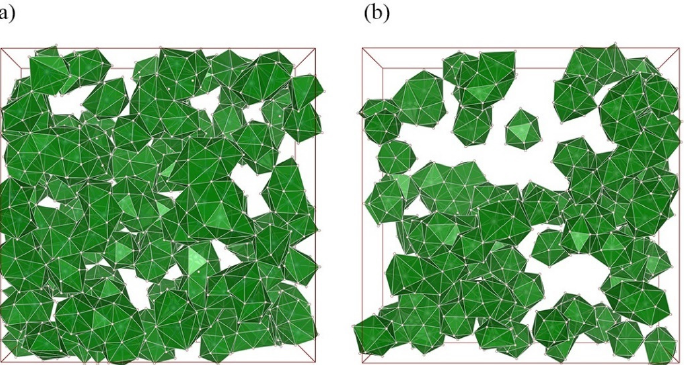
Figure 7. The distribution of FIs and their networking in the simulated cells for the Al 35 Mg 35 Zn 30 and Al 25 Mg 25 Zn 50 metallic glasses. For clarity, only the front half of the icosahedral network is shown in both ( a , b ).